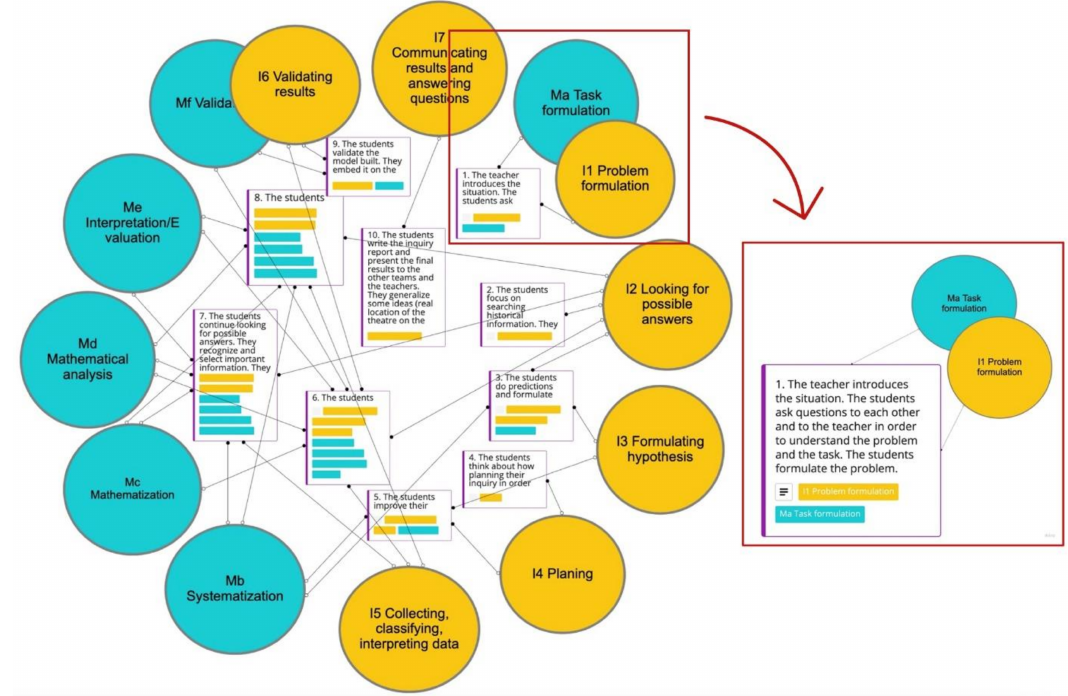
Figure 5. Representation of relationships between the sub-processes of inquiry and the sub-processes of mathematical